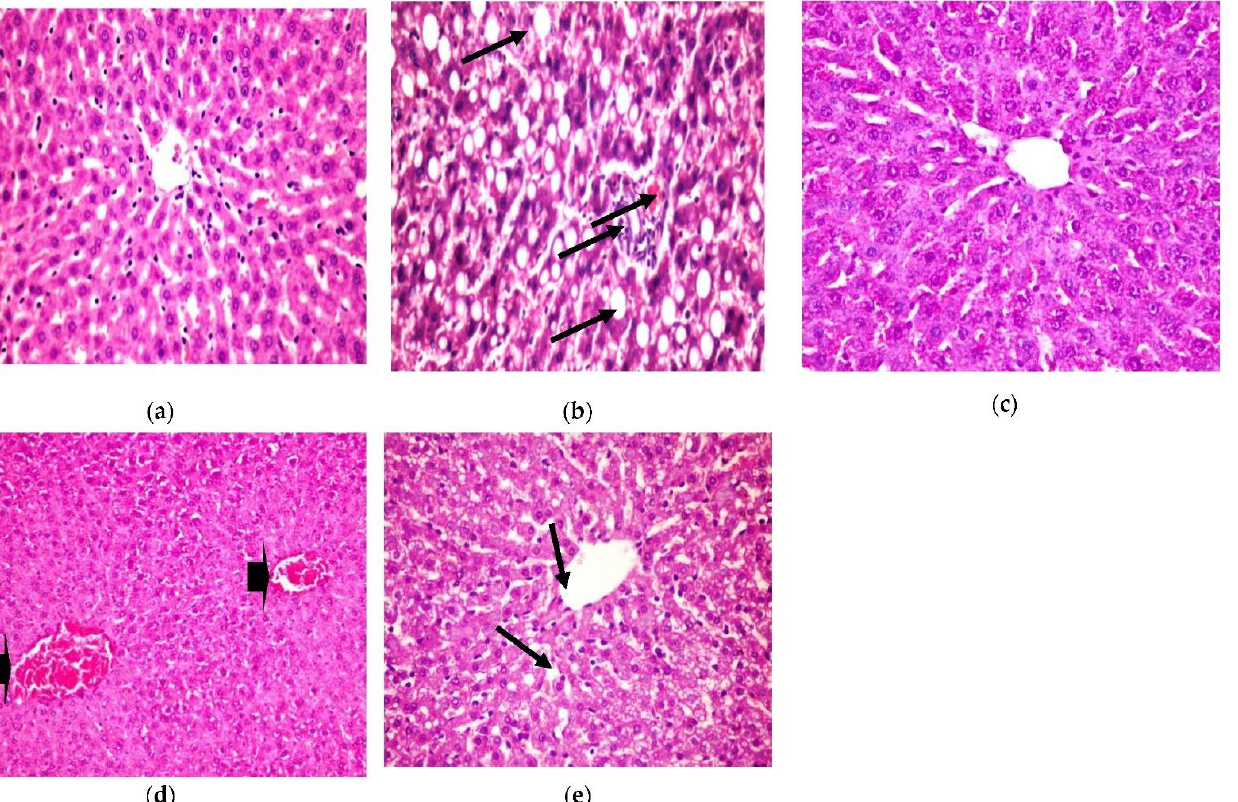
Figure 5. Histopathological examination for (1) liver. ( a ) Liver from the standard group, ( b ) liver from positive diabetic rats, ( c ) liver from the group treated with CRB (Lesion Score: 0), ( d ) liver from the group treated with CRB (Lesion Score: +) and ( e ) liver from the group treated with standard drug (Lesion Score: ++).